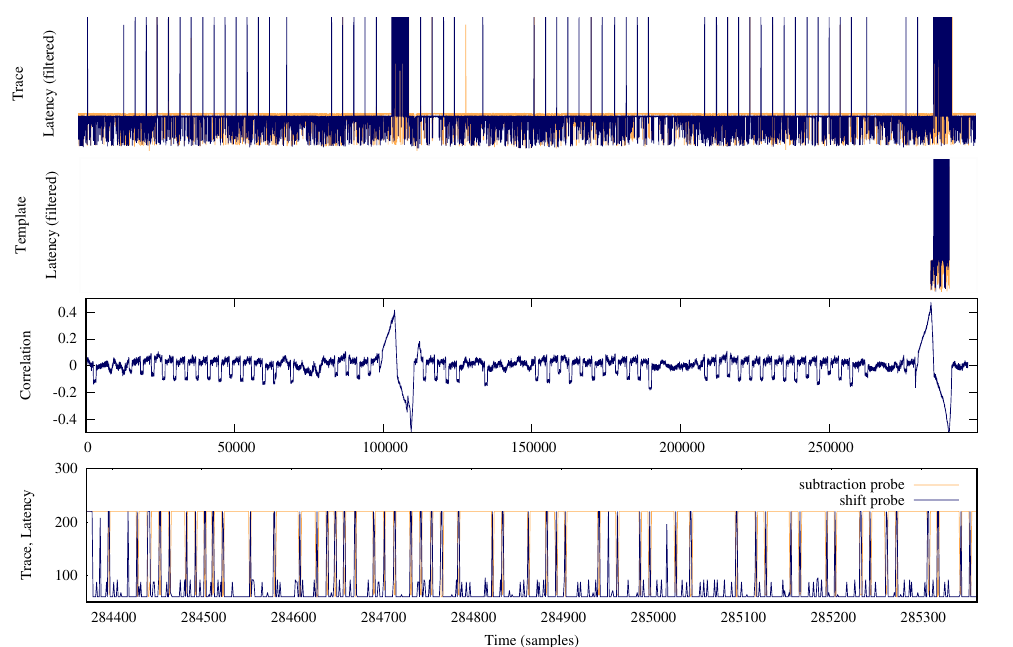
Figure 4: Visualization of the moving Pearson correlation in action. From top to bottom: filtered trace, aligned template trace, Pearson correlation, and raw trace